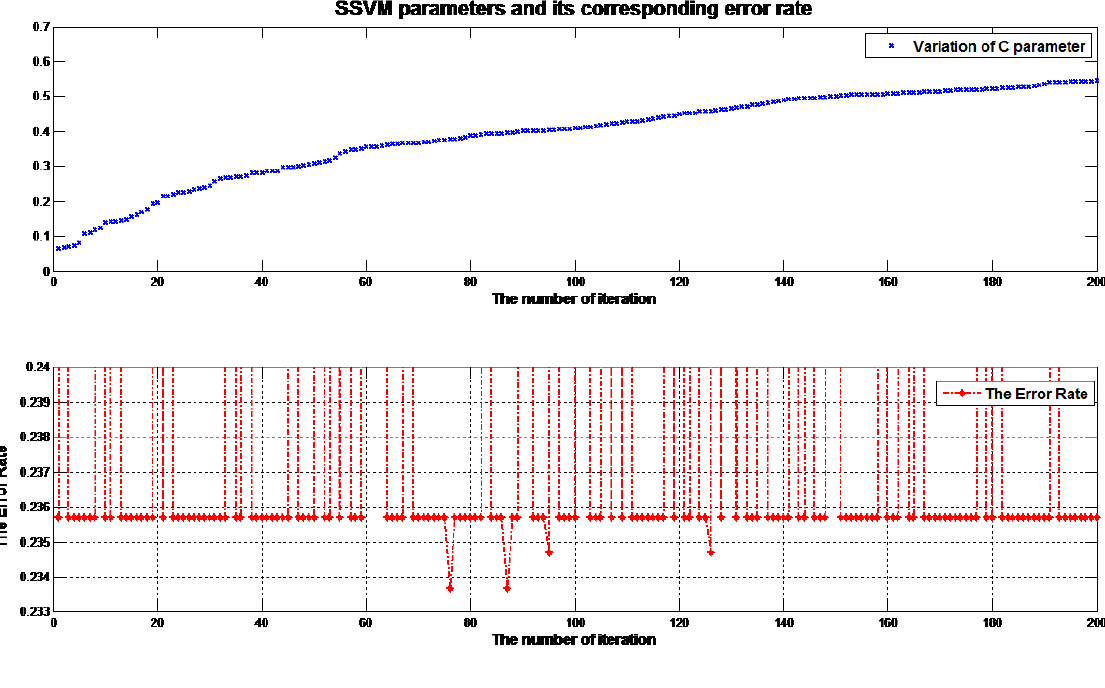
Figure 7. Sensitivity analysis of C parameter (Error rate with different C)